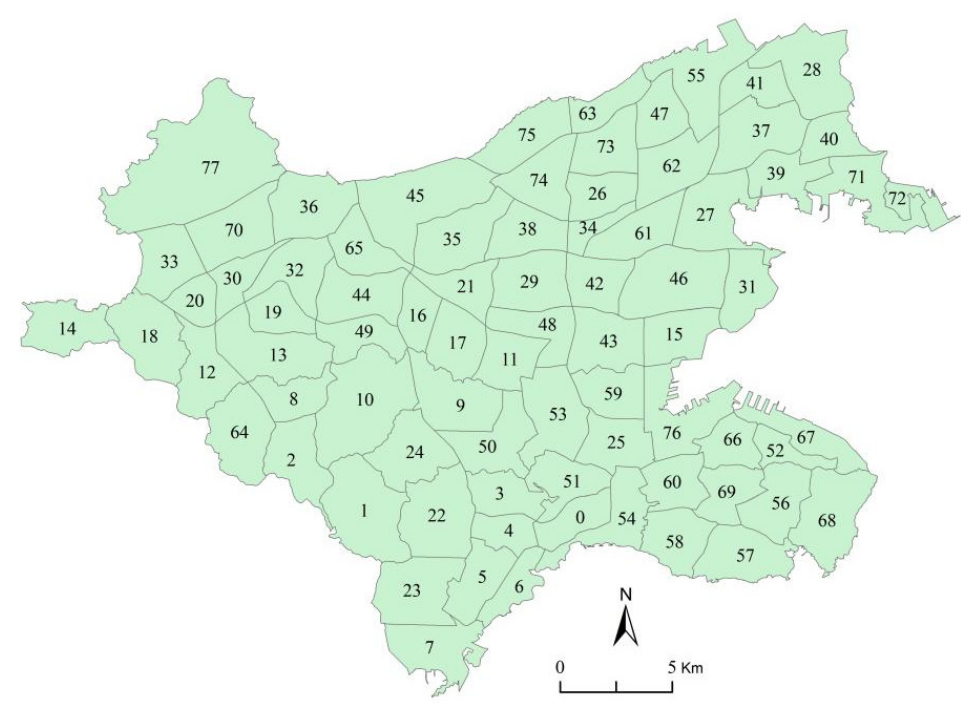
Figure 2. Location and serial number of the 78 blocks in Dalian.